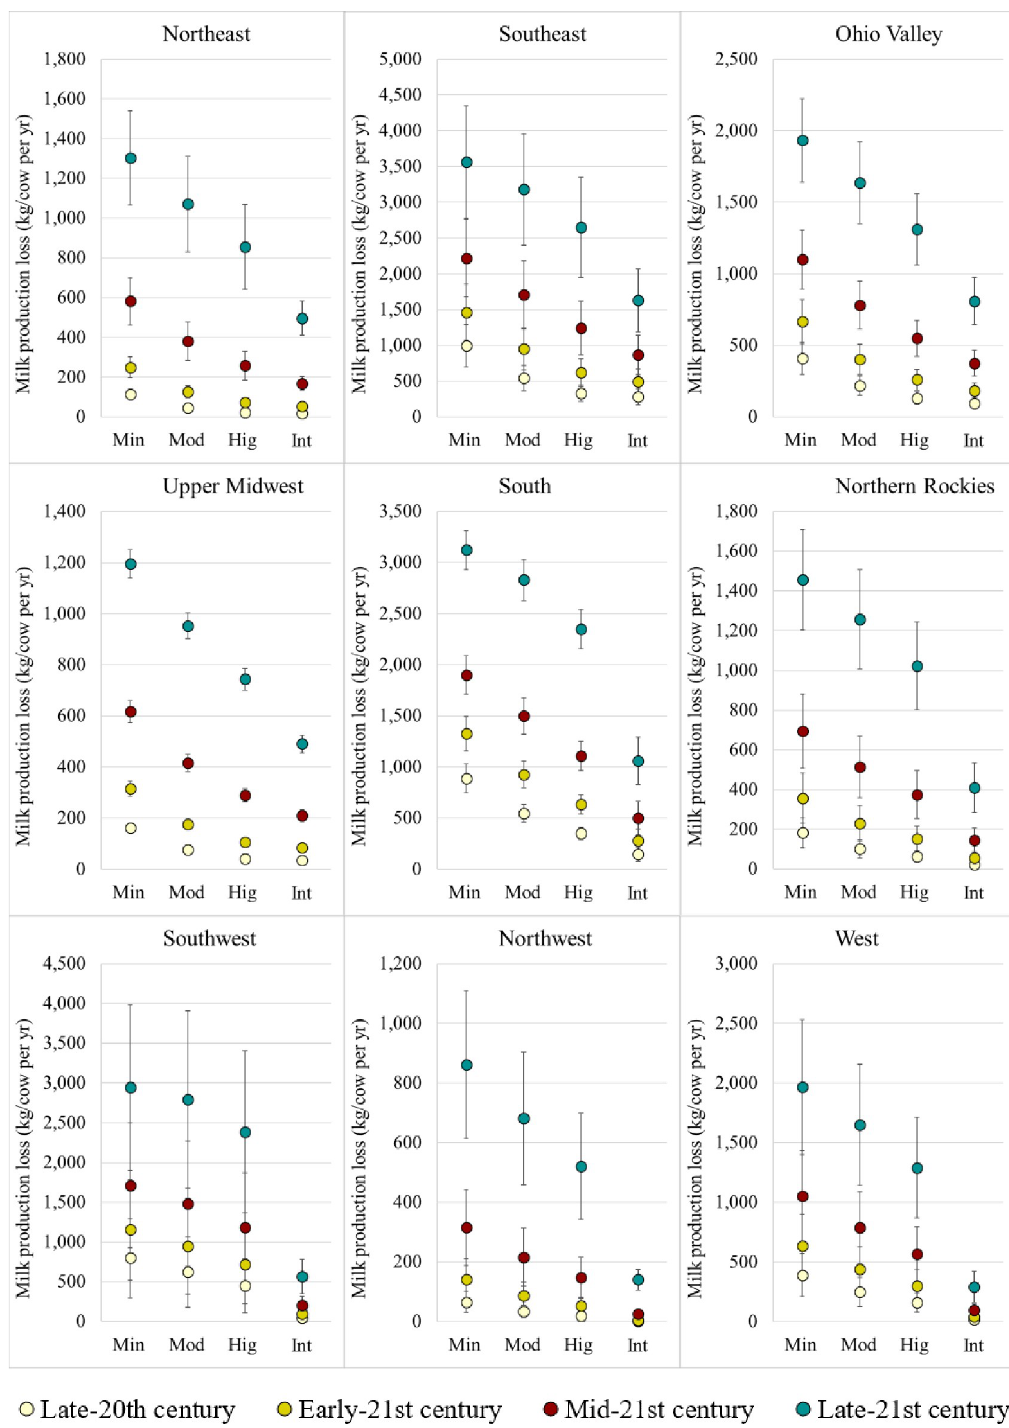
Fig 5. Mean annual milk production loss (with error bars) by climate region, period, and heat abatement (Min: Minimal; Mod: Moderate; Hig: High; Int: Intense).